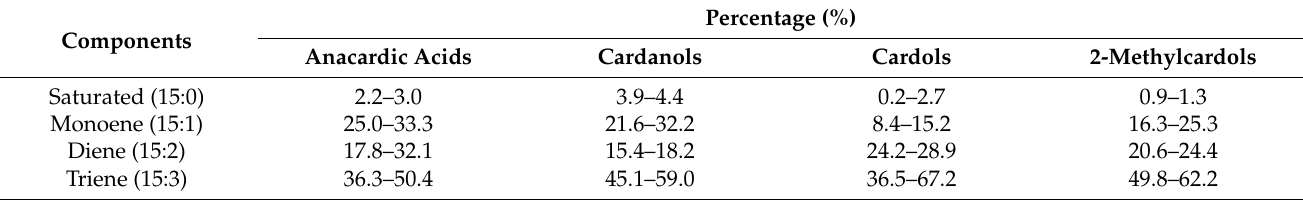
Table 1. Relative percentage composition of unsaturated phenolic constituents of natural CNSL, quantified by GC/MS.